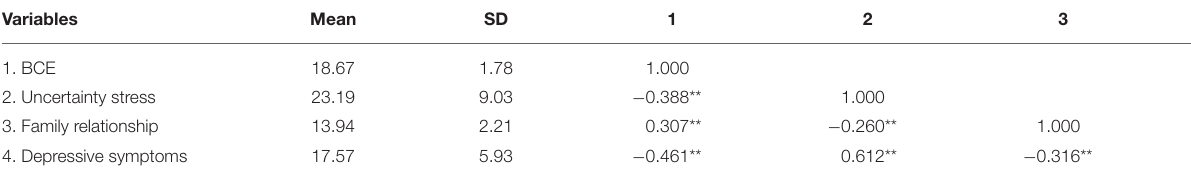
TABLE 2 | Correlation between BCE, uncertainty stress, family relationship, and depressive symptoms among adolescents. Variables